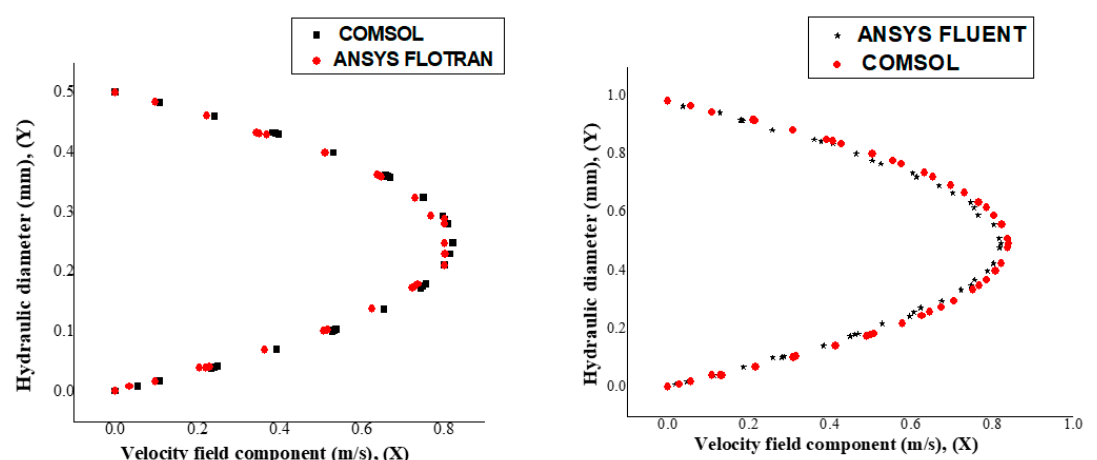
Figure 4. Velocities profiles of di ff erent channels with a di ff erent hydraulic diameter at di ff erent velocity inlet.